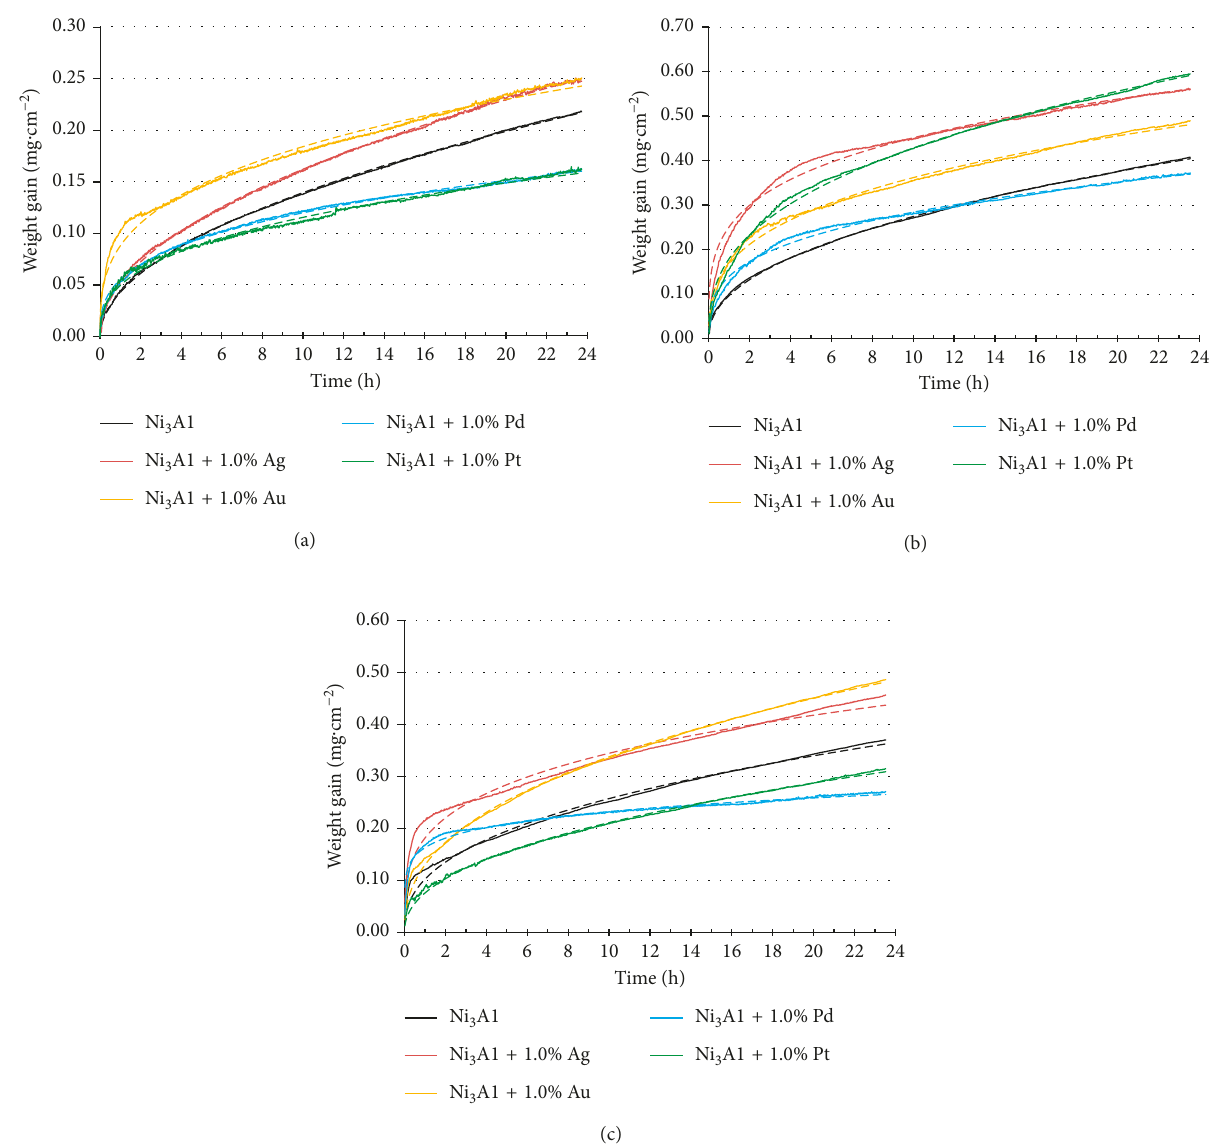
° C, (b) 1000 ° C, and (c) 1100 ° 2 at (a) 900